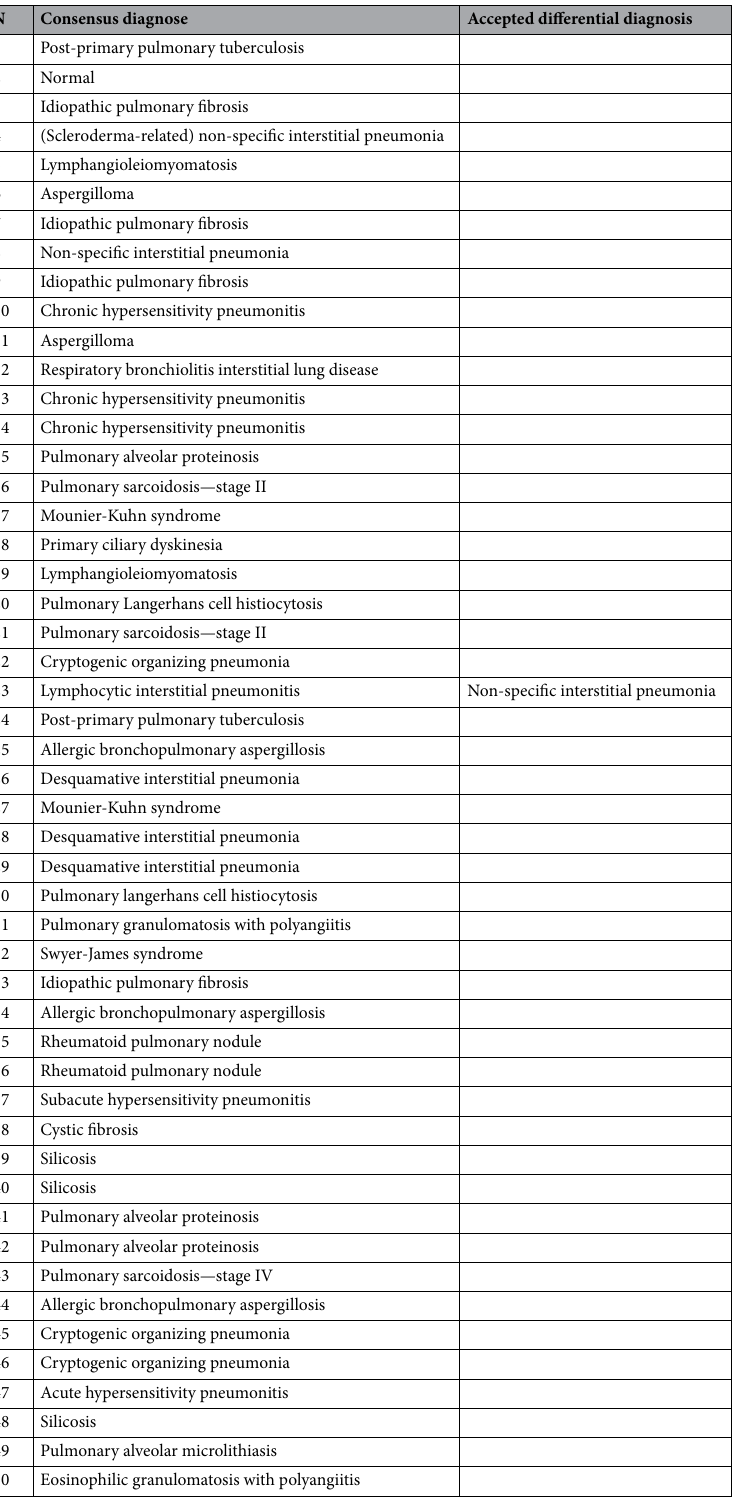
Table 1. Diagnoses of the validation